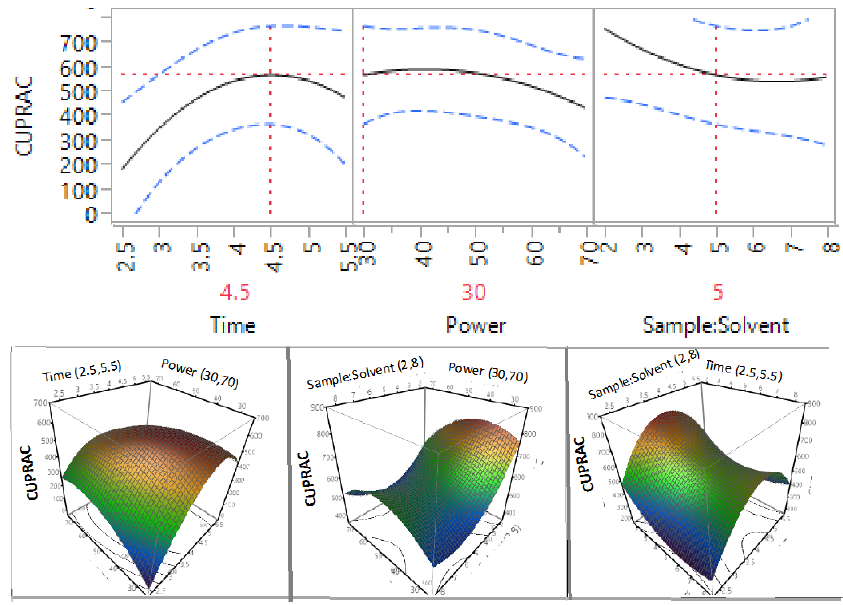
Figure 9. Impact of time (2.5–5.5 min), power (30%–70%, 360–840 W) and sample-to-solvent ratio (2–8 g/100 mL) on CUPRAC (µM TE/g).